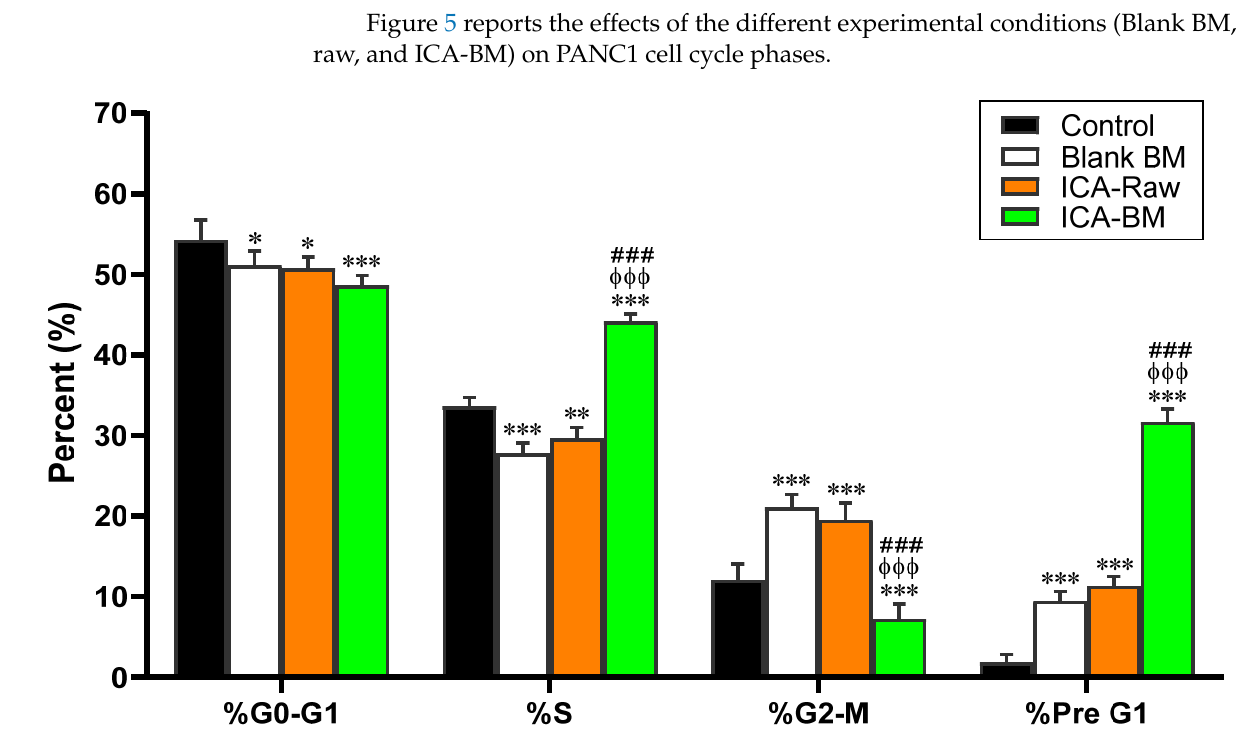
Figure 5. Effect of Blank BM, ICA-Raw, and ICA-BM on PANC1 cell cycle phases. Data are the mean of 4 independent experiments ± SD. * Significantly different vs. Control ( p < 0.05); ** Significantly different vs. Control ( p < 0.01); *** Significantly different vs. Control ( p < 0.001); φφφ Significantly different vs. Blank BM ( p < 0.001); ### Significantly different vs. ICA-Raw ( p < 0.001).